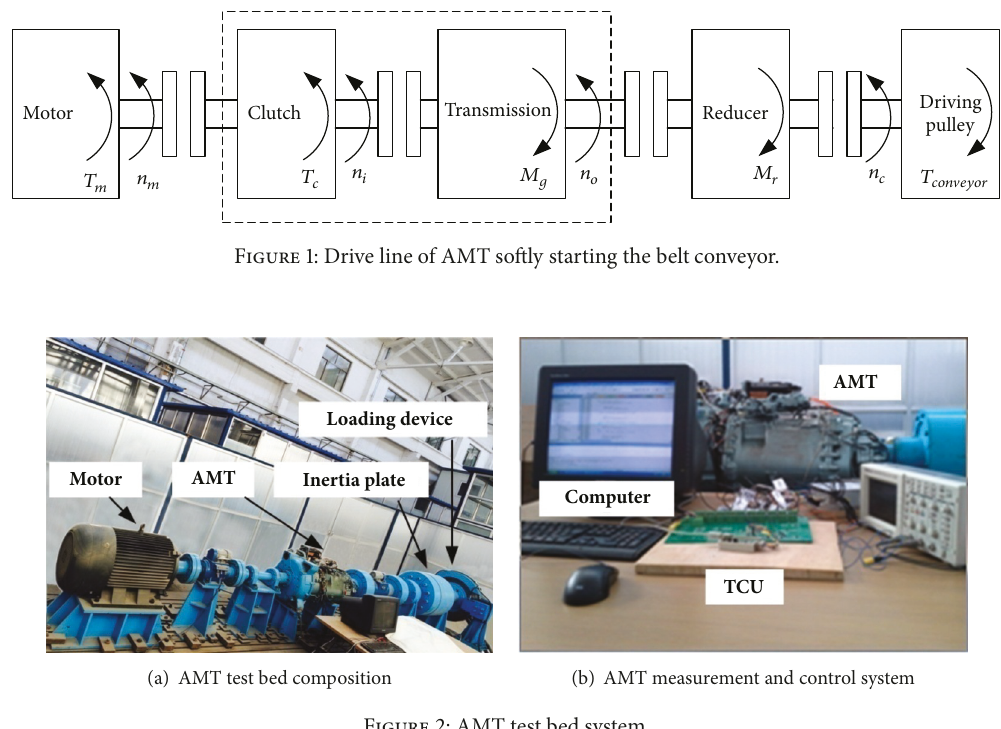
Figure 2: AMT test bed